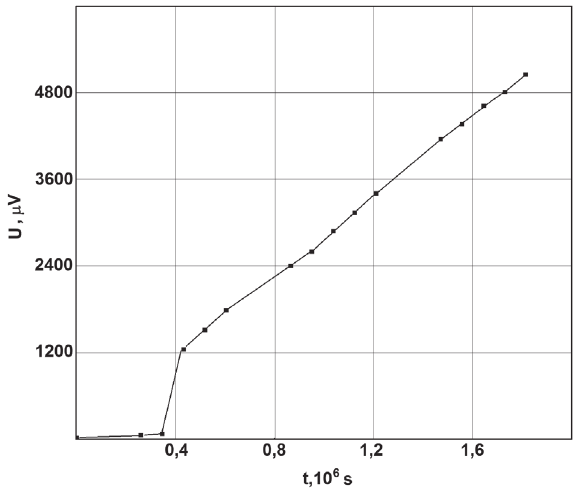
Figure 3. Change in the difference of potentials for the CSRI (BN) specimen irradiated with neutrons to a dose of 1.0·10 15 n/cm 2